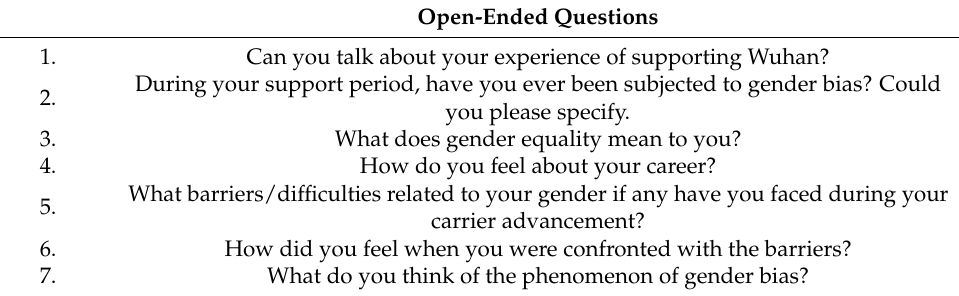
Table 1. Interview questions.